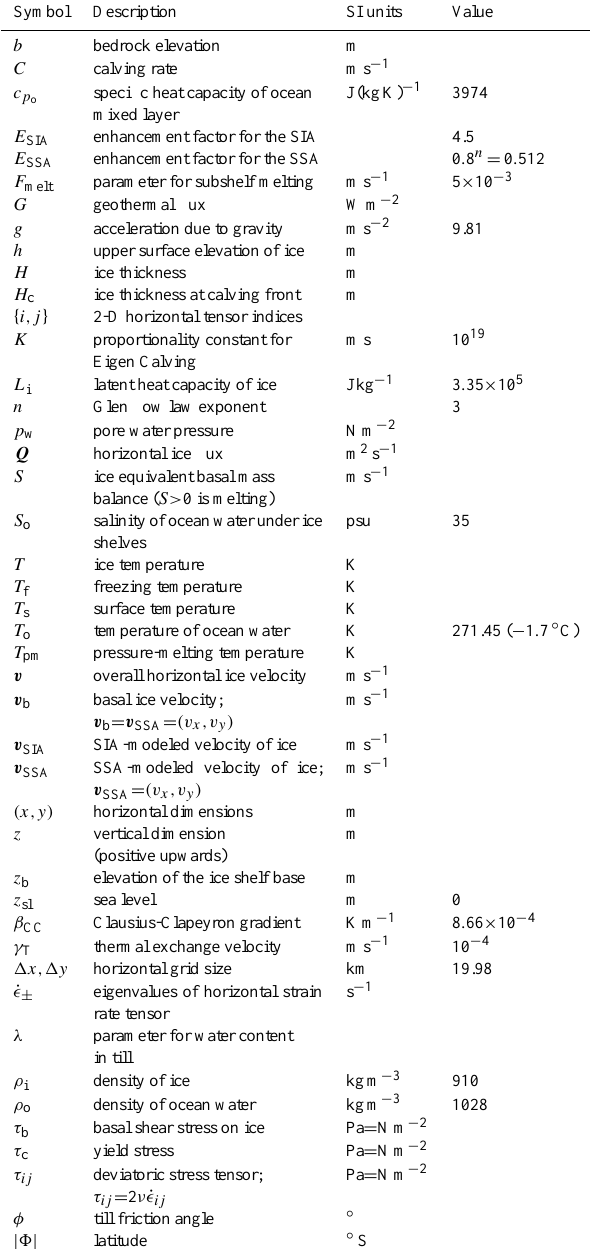
Table A1. Table of symbols and values of constants. Symbol Description SI